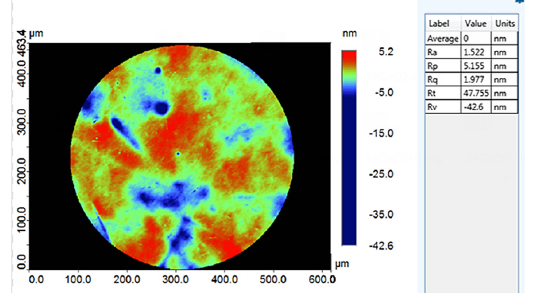
Fig. 5. Final surface shape error of primary mirror. Surface roughness is also measured by using Bruker white light interferometer, and the roughness is about 1.5nm~3nm in Ra. Figure 6 show one of the results of primary mirror.